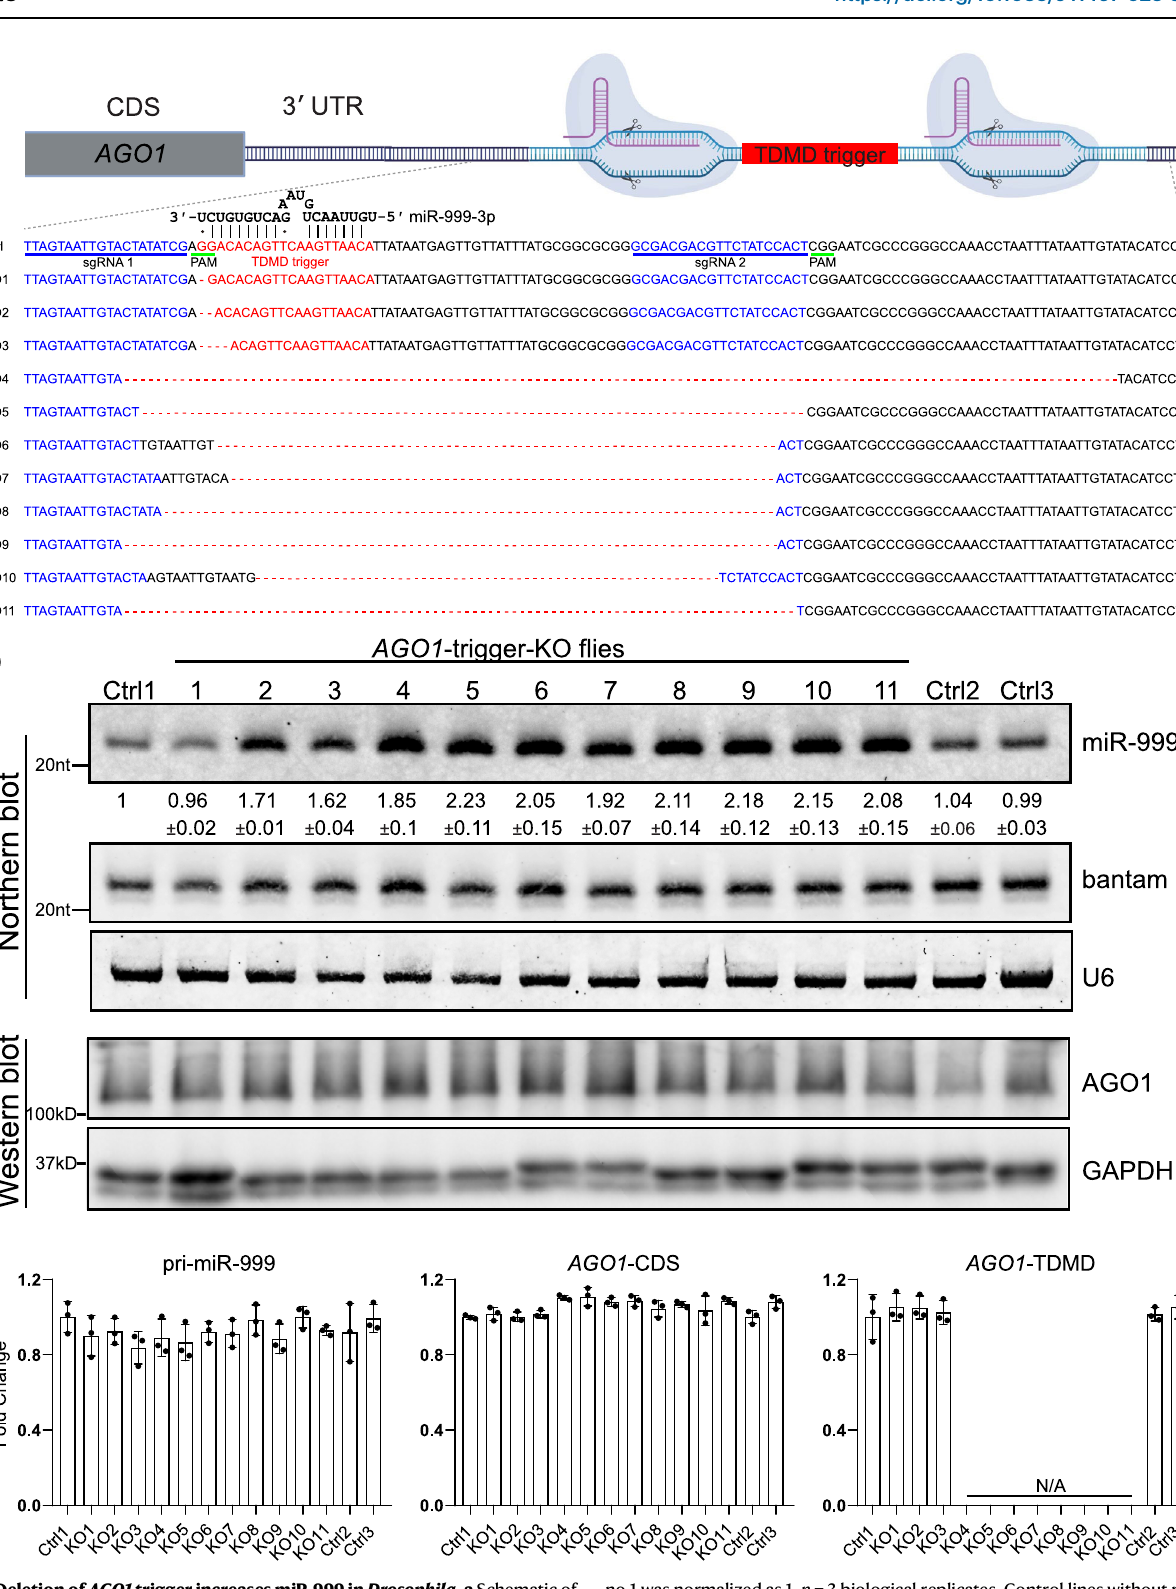
Fig.6|Deletionof AGO1 triggerincreasesmiR-999in Drosophila .a Schematicof the CRISPR-Cas9-mediated knockout of miR-999 TDMDtrigger from AGO1 3 ′ UTR. The trigger and sgRNA sites are highlighted in red and blue, respectively. PAM sequence is underlined (green).The genotypeofeach mutant line isshown below. Cartoonswerecreated withBioRender.com. b Upperpanel:northernblotanalyses of miR-999, bantamandU6incontrolsand AGO1 triggermutantlines.Bantamand U6 served as loading controls. The normalized miR-999 abundance (compared to bantam)areshownbeloweachmiRNAband.ThemiRNAabundanceincontrolline